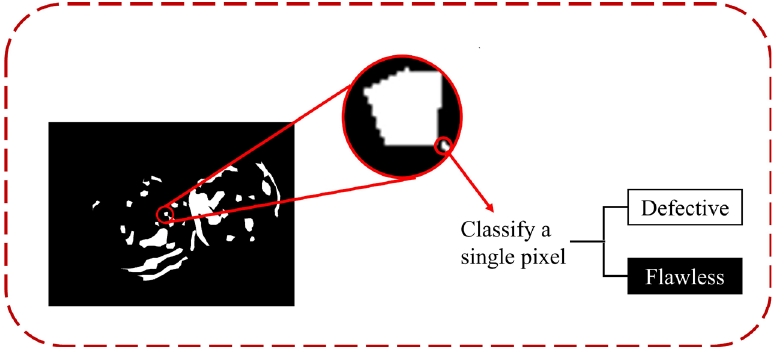
Figure 4. Converting the pixel-level segmentation problem into a binary classification problem and classifying the sample as a single pixel.